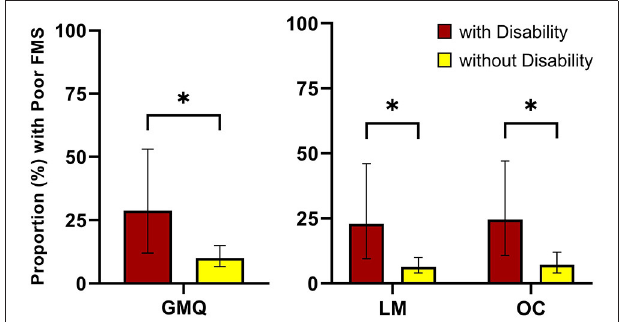
FIGURE 1 | Gross motor quotient and subscale scores between children with and without disabilities. GMQ, gross motor quotient; LM, locomotor subscale; OC, object control subscale. * p ≤ 0.05.